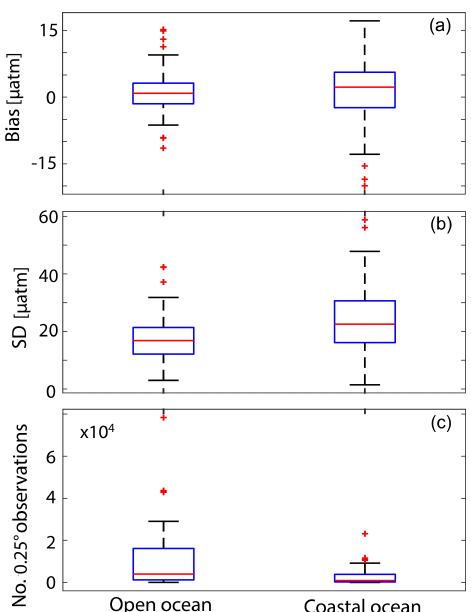
Figure 3. Schematic illustration of the merging steps. Step 1 shows an illustrative example of one 30 ◦ × 30 ◦ box that includes both coastal- and open-ocean SOCAT observations. In Step 2 empty grid cells within the 30 ◦ × 30 ◦ box are filled with coastal ocean as well as open-ocean data points, and in Step 3 open-ocean and coastal-ocean data points are combined where both exist.